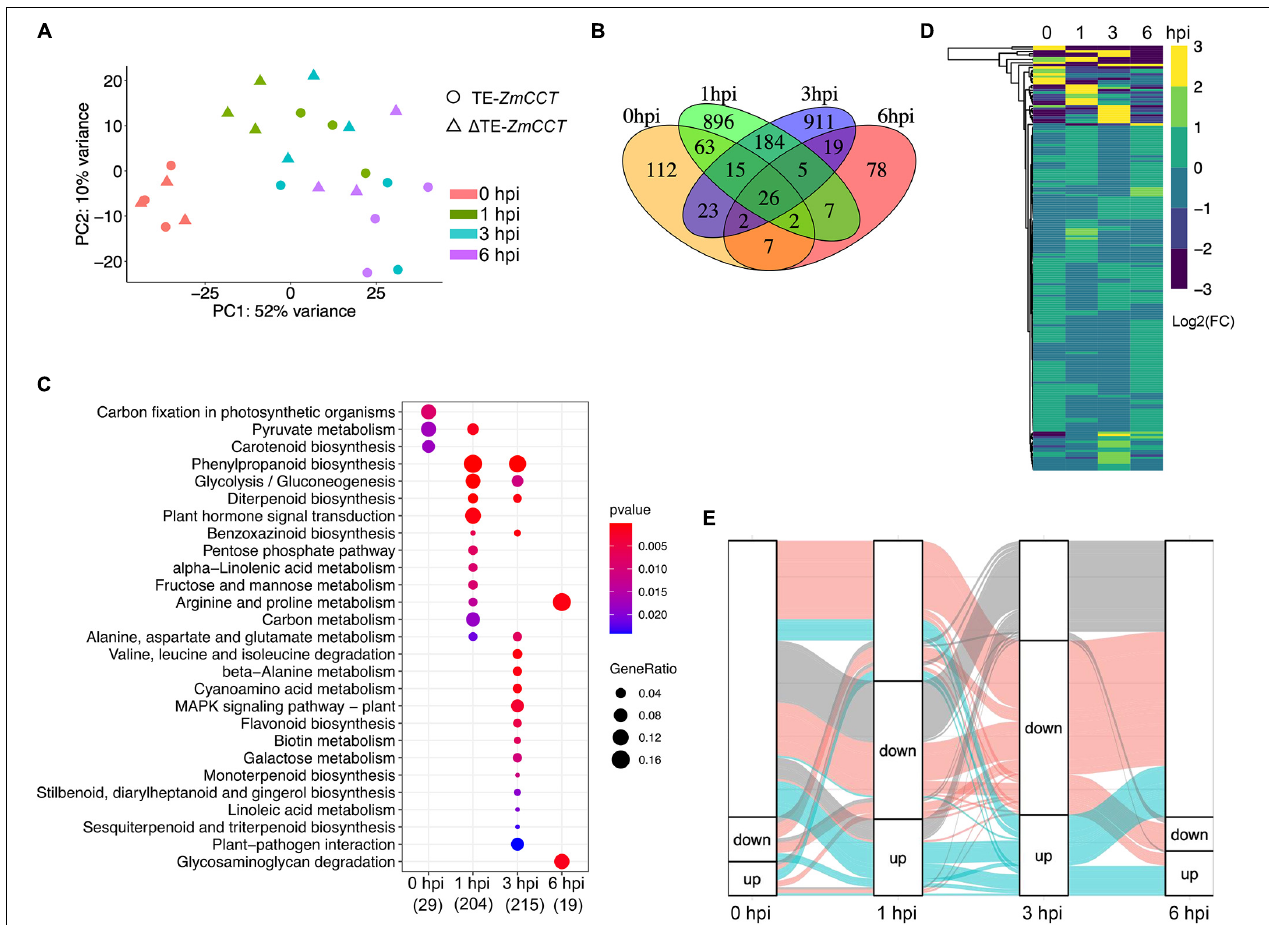
FIGURE 2 | Early-stage resistance to GSR by reprogramming maize transcriptomics. (A) The plot showing the principal component analysis (PCA) of maize transcriptomics from Y331- (cid:49) TE and Y331 at four different time points. Normalized reads count was used. (B) A Venn diagram showing the numbers of differentially expressed genes (log2| FC| > 1, padj < 0.05) detected in RNA-seq at 0, 1, 3, and 6 hpi. (C) The KEGG pathway enrichment analysis using DEGs detected in RNA-seq. (D) A heatmap showing relative expression using log2| FC| values from our RNA-seq to demonstrate the expression of ortholog genes between maize and Arabidopsis . The Arabidopsis RNA-seq data were reported as transcriptionally induced genes responding to fungal elicitor (2021, Nature Plant). (E) Alluvial plots of a fraction of a number of differentially expressed genes during infection stages. Each panel shows one time point, and each line represents a different group of DEGs. Red and blue highlight the fractions of DEGs detected at 3